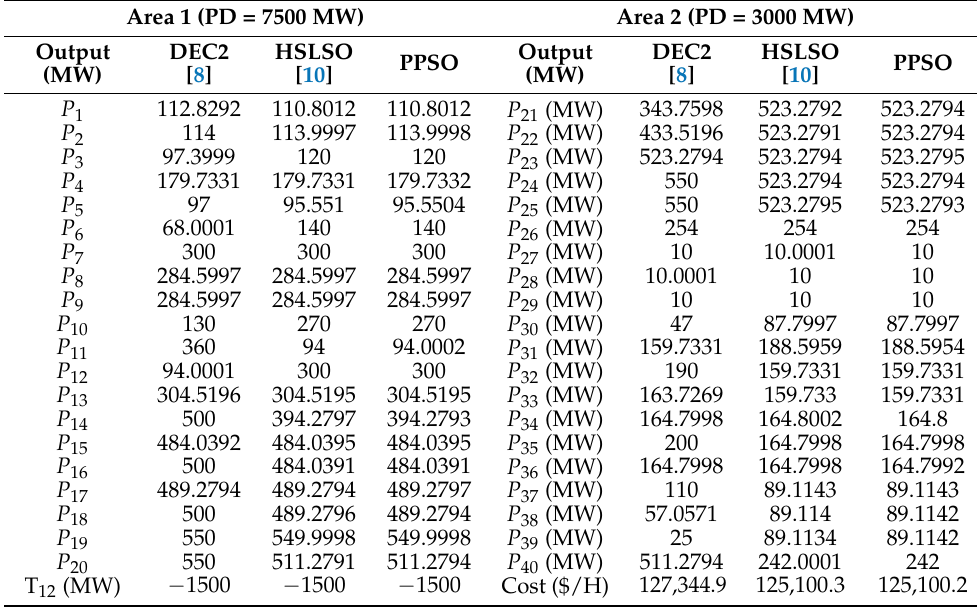
Table 3. Best solutions obtained for the large-scale test system.